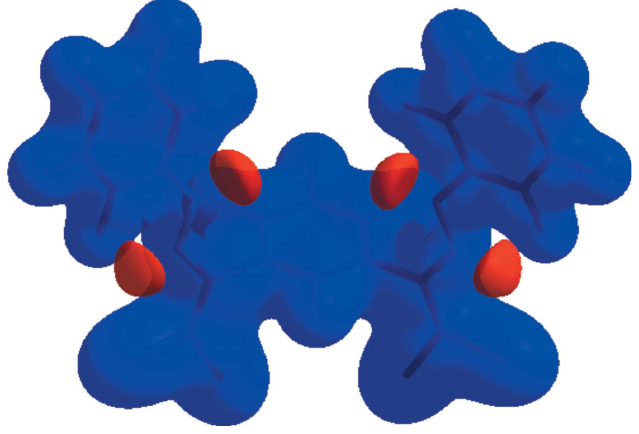
Figure 5 View of the three-dimensional Hirshfeld surface of the title complex plotted over electrostatic potential energy in the range (cid:4) 0.1379 to 0.1988 a.u. using the STO-3G basis set at the Hartree–Fock level of theory. The hydrogen-bond donors and acceptors are viewed as blue and red regions around the atoms corresponding to positive and negative potentials, respectively.